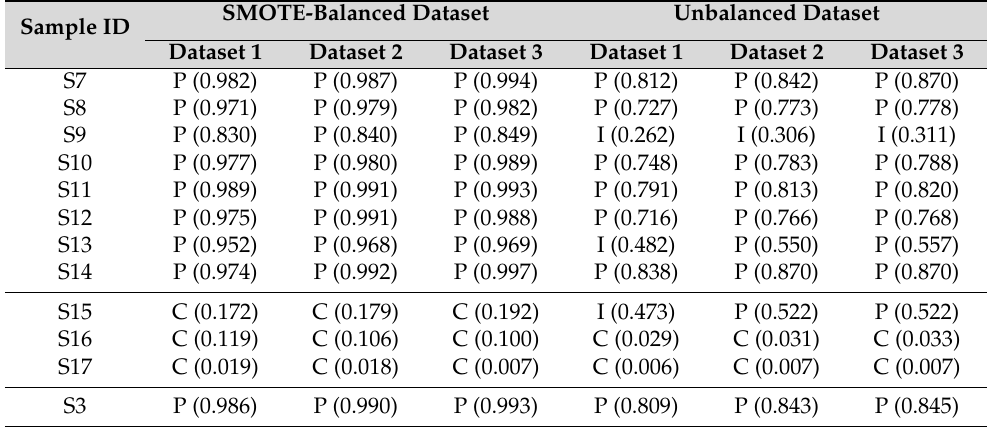
Table 3. Training sample size requirement for NSD1 variant classification using the SVM classifier